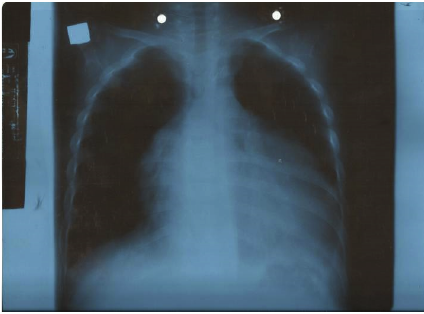
Figure 1: Plain film shows a “boot shaped” heart with an upturned cardiac apex due to right ventricular hypertrophy and concave pulmonary arterial